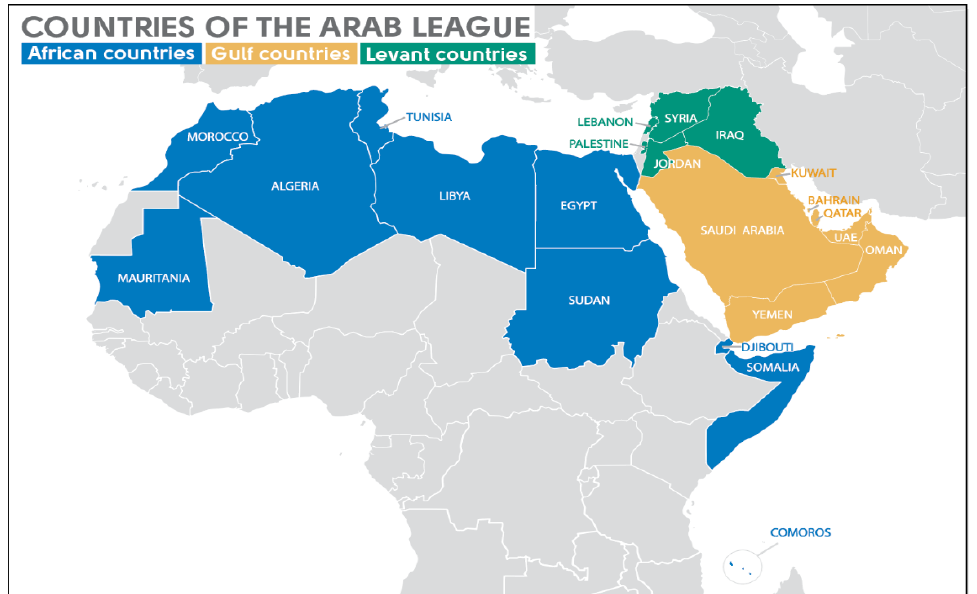
Figure 1. Map of the Arab League countries. The Arab League is a regional organization in the Arab world, which is located in Africa and Western Asia. It can be geopolitically subdivided into three main regions, the Gulf countries, the Levant countries, and the African countries. The Gulf countries of the Arab League are the members of the Gulf Cooperation Council (GCC) (Bahrain, Kuwait, Oman, Qatar, Saudi Arabia, and United Arab Emirates (UAE)) and Yemen. The Levant countries of the Arab League are Iraq, Jordan, Lebanon, Palestinian territories, and Syria. The African countries of the Arab League are Algeria, Comoros, Djibouti, Egypt, Libya, Morocco, Mauritania, Somalia, Sudan, and Tunisia.